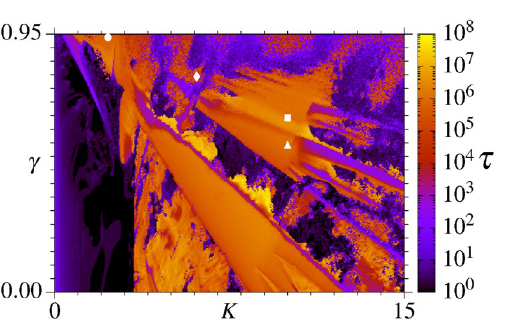
Figure 5. RC’s lifetime τ in colors according to the color bar (in logarithm scale) in the parameter space for β = 10 − 4 and N = 128 elastically interacting particles in system (Eq.